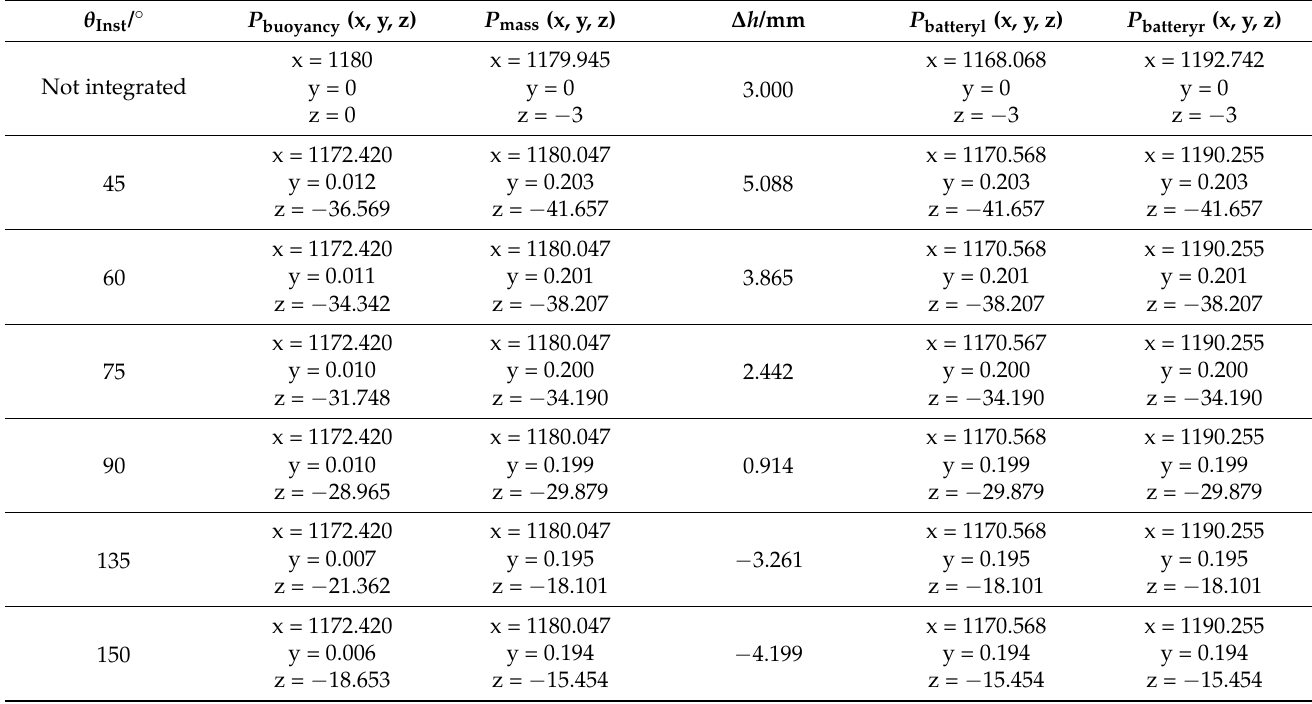
Table 1. Between center of mass and buoyancy of the integrated vehicle at different installation angles.